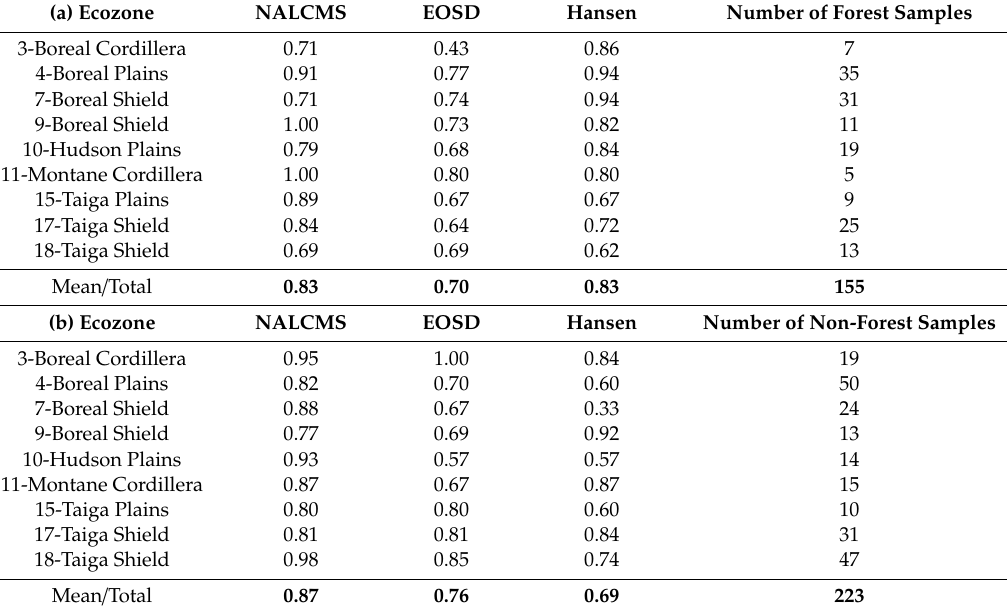
Table 6. ( a ) The fraction of forest and samples correctly identified by NALCMS, EOSD and Hansen2010 (adjusted using forest loss / gain data from Hansen2000); ( b ) The fraction of non-forest samples correctly identified by NALCMS, EOSD and Hansen2010 (adjusted using forest loss / gain data from Hansen2000).